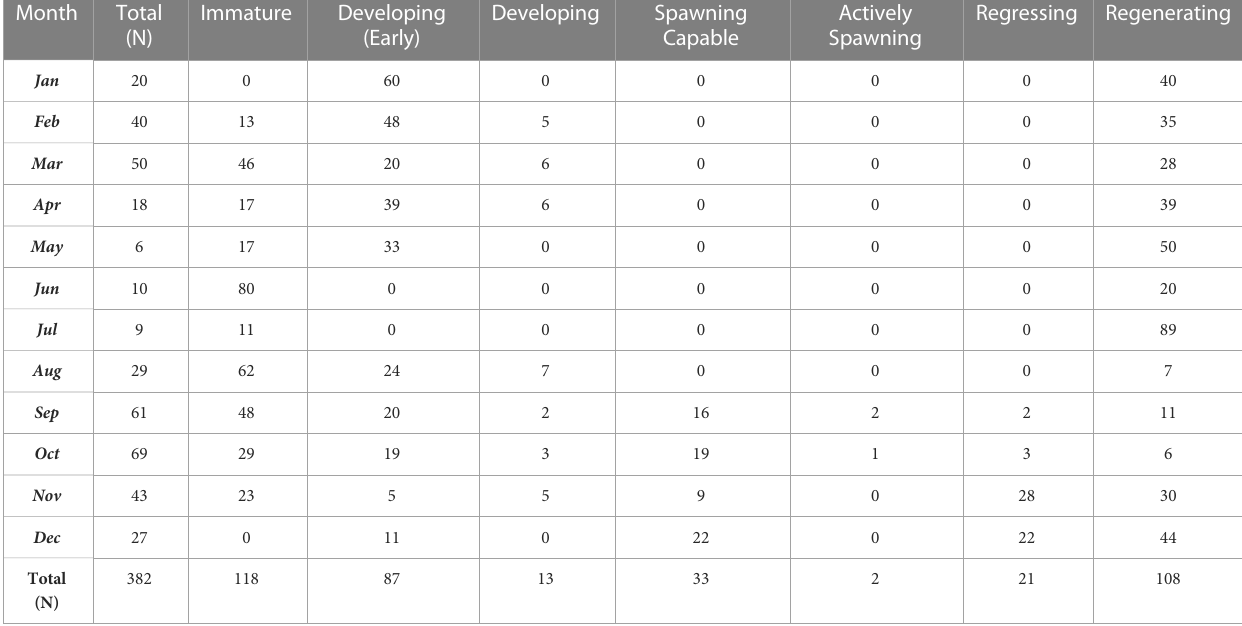
TABLE 3 Monthly percentages of female Etelis coruscans in each reproductive phase captured from the main Hawaiian Islands during October 2007 to December